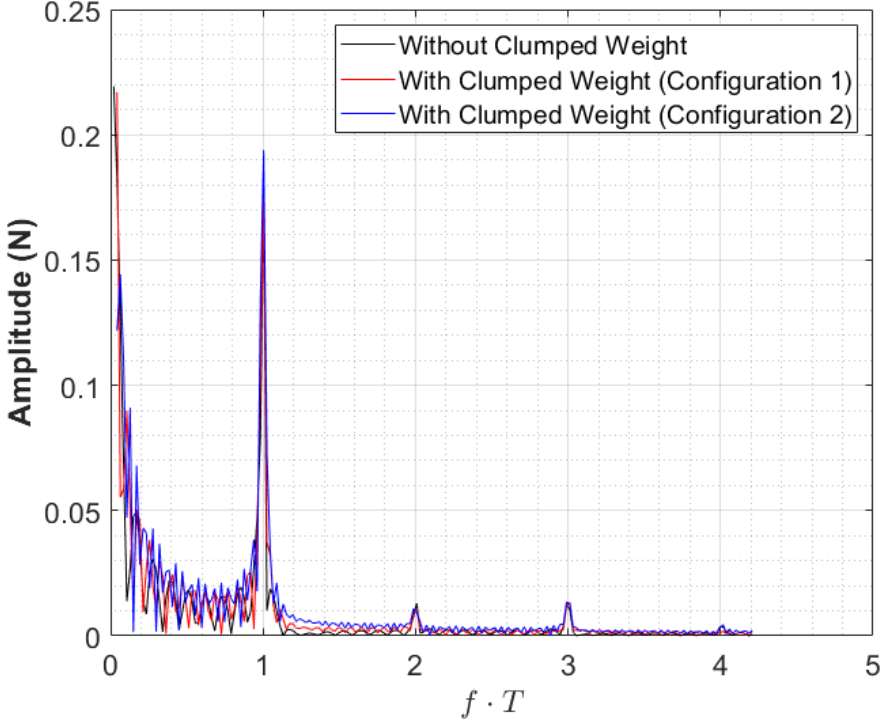
Figure 14. Spectrum plot of the top-end tensions for an amplitude of A = 0.175 s and period T = 3.5 s for the three tested